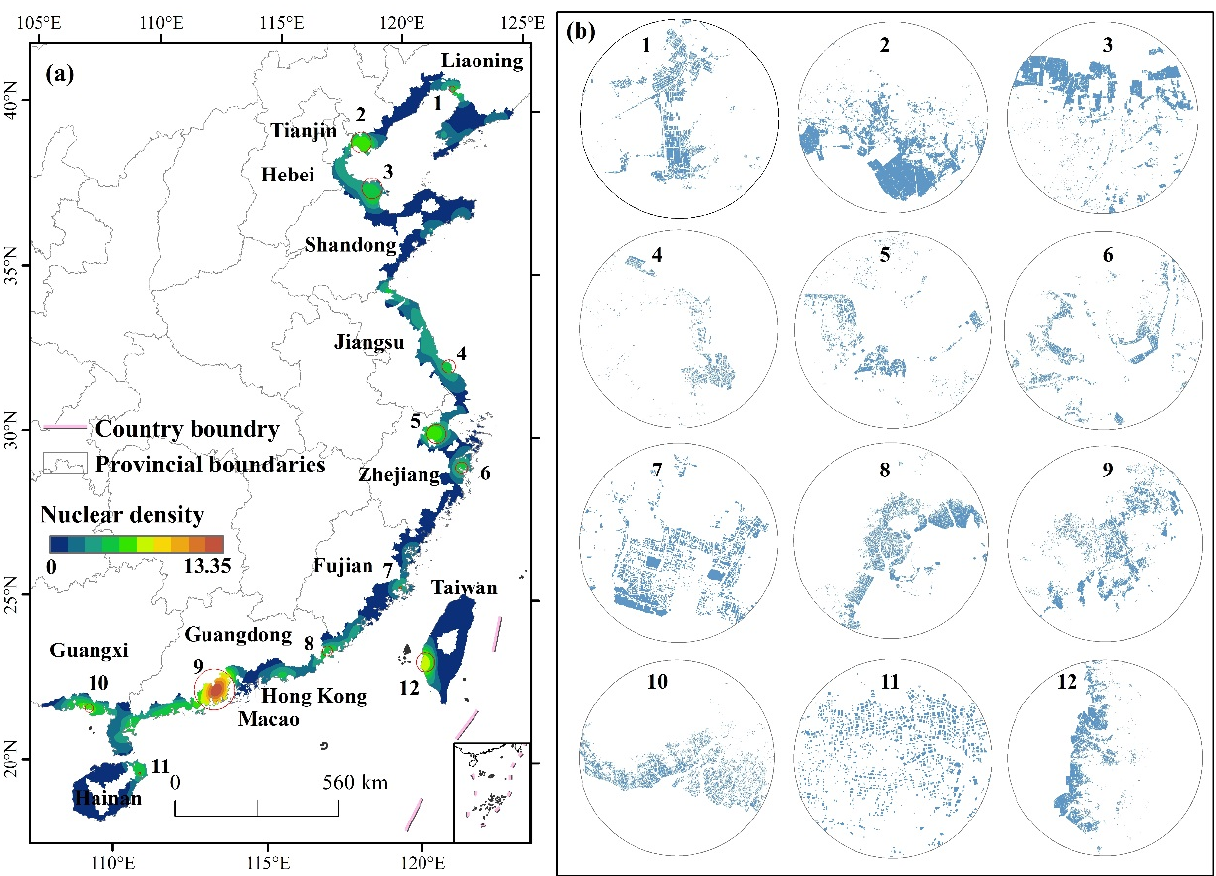
Figure 8. Spatial agglomeration characteristics of aquaculture ponds along the coast of China. (a) Characteristics of nuclear density distribution in aquaculture ponds; and (b) distribution characteristics of aquaculture ponds in areas with high nuclear density.